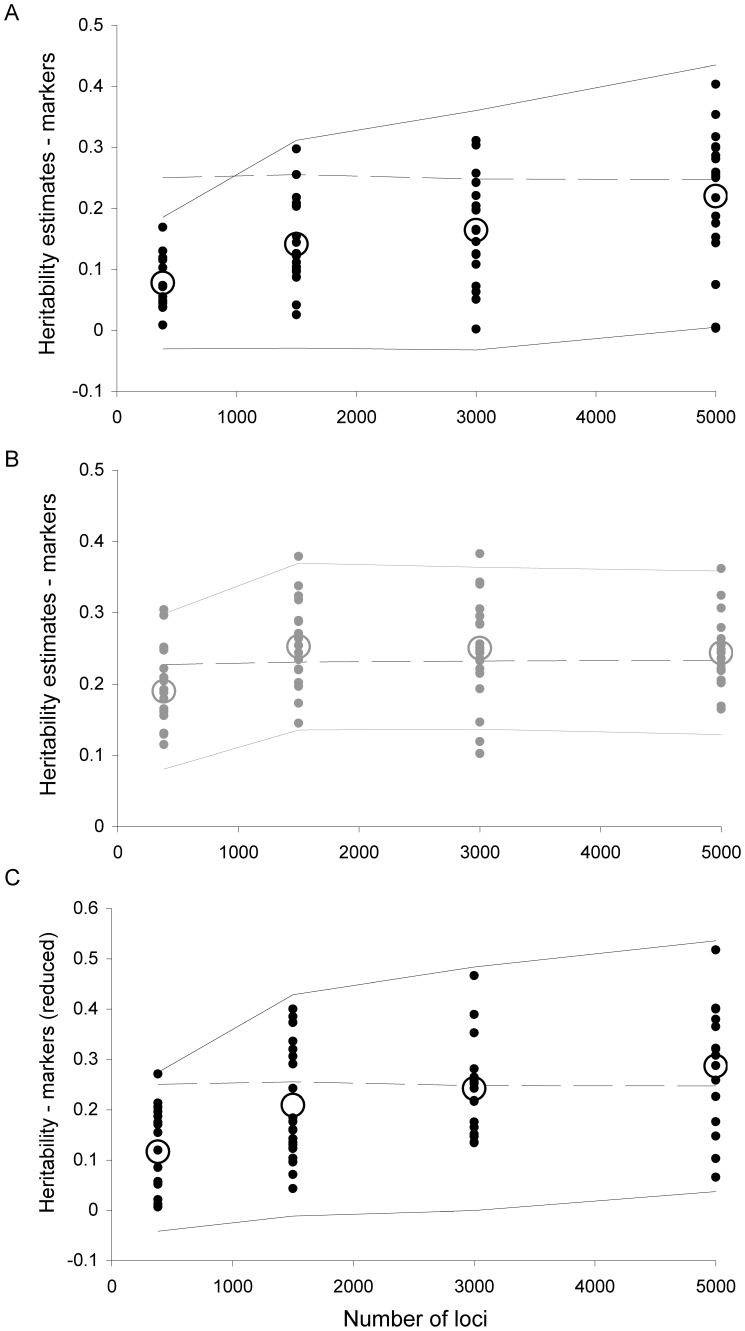
Heritability estimates become more accurate with the number of marker loci used to estimate relatedness.Influence of the number of loci used to estimate pairwise relatedness coefficients (Loiselle coefficients) on the bias in heritability estimates, when using a marker-based animal model. Each dot stands for a simulated population of 500 individuals, with complete outcrossing (panel A, in black) or 90% selfing (panel B, in grey). Panel C shows the results when marker-based relatedness coefficients are truncated before the analysis. Large circles stands for the average heritability over the 20 replicated simulations. The confidence intervals estimated in Asreml for each replicate were averaged over the 20 replicates and are shown as solid lines. The dashed line stands for the simulated heritability.